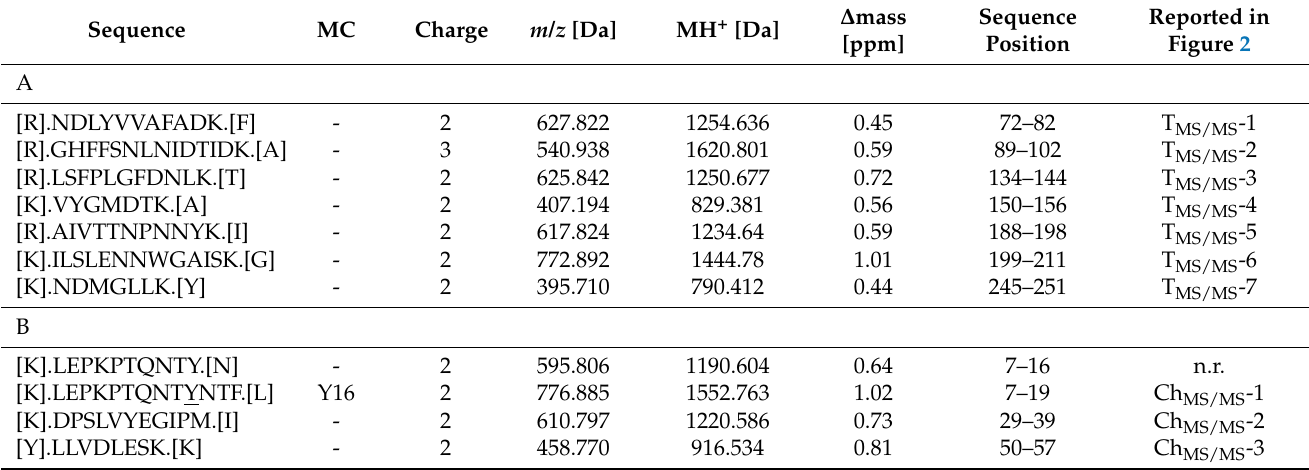
Table 1. Amino acid sequences of both tryptic (A) and chymotryptic (B) peptides from quinoin obtained by high-resolution nanoLC-Tandem Mass Spectrometry. Sequence, number of missed cleavages sites (MC), experimental masses of precursor ions, charge state and theoretical molecular weights of peptides (MH + ) together with mass accuracies are reported. Sequence MC Charge